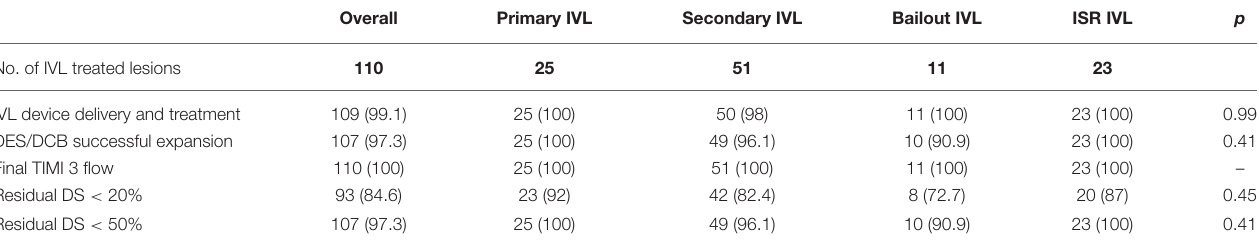
TABLE 5 | Effectiveness endpoints in the overall population and patient